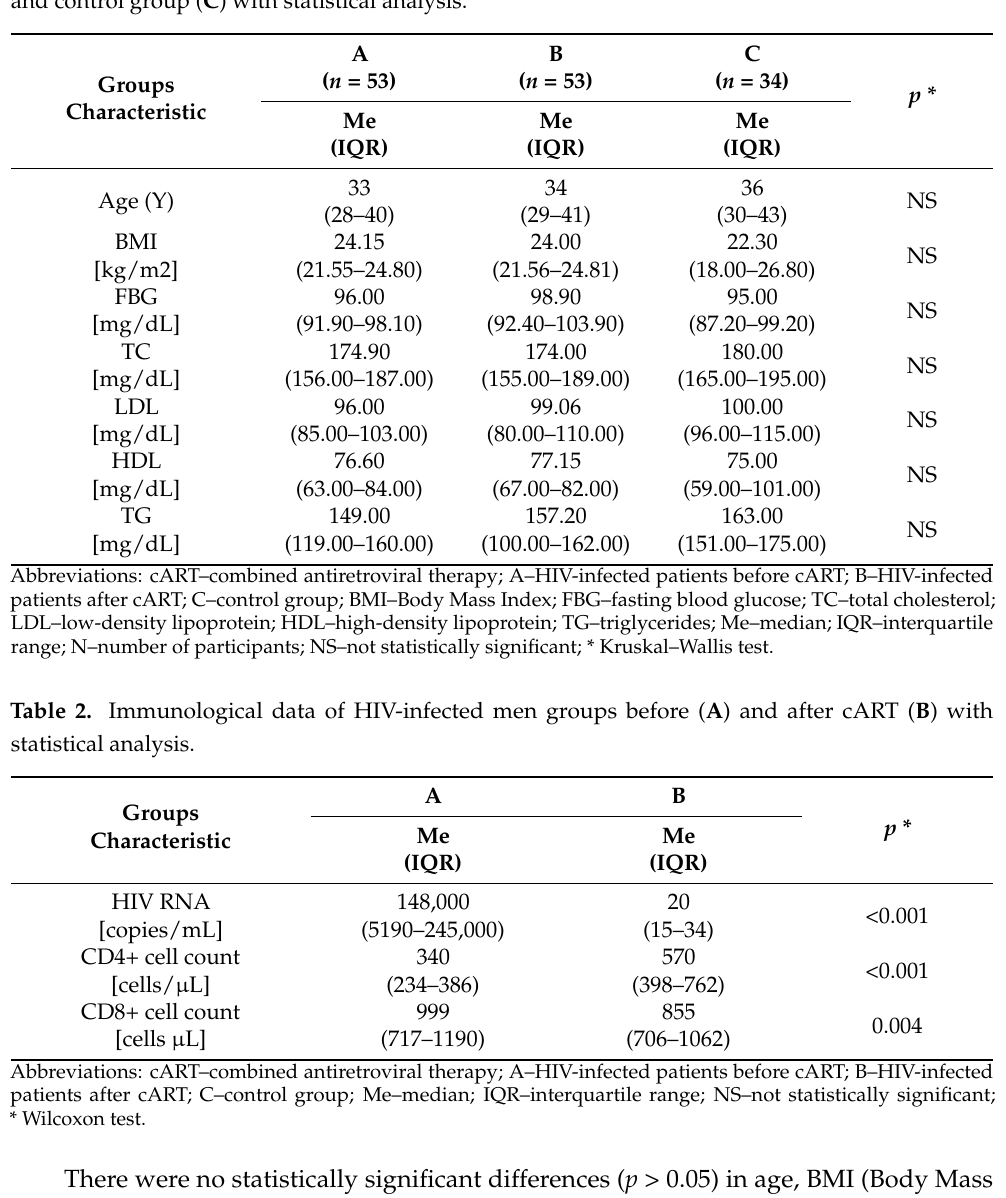
Table 1. Demographic and biochemical data of HIV-infected patients before ( A ) and after cART ( B ) and control group ( C ) with statistical analysis.